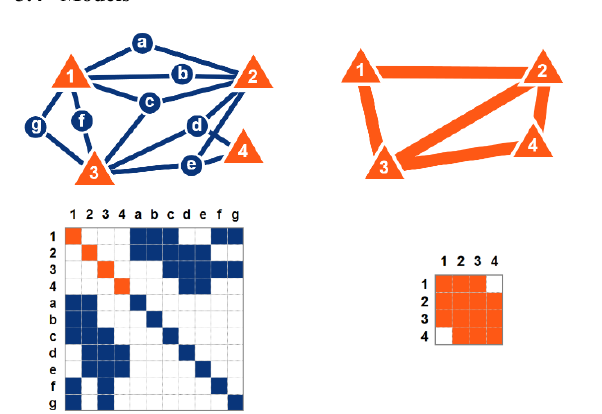
Figure 2: diagram and normal equations associated to parametric (left) and Gauss-Helmert (right) models